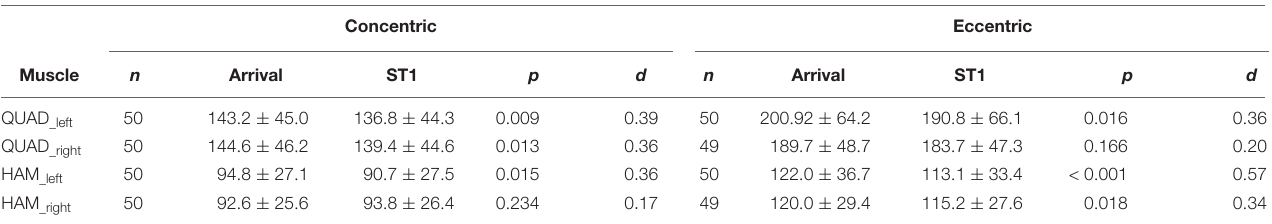
TABLE 2 | Concentric and eccentric isokinetic strength test of the recreational ski mountaineers, on the arrival day and after the first day of ski mountaineering (ST1). Concentric Eccentric